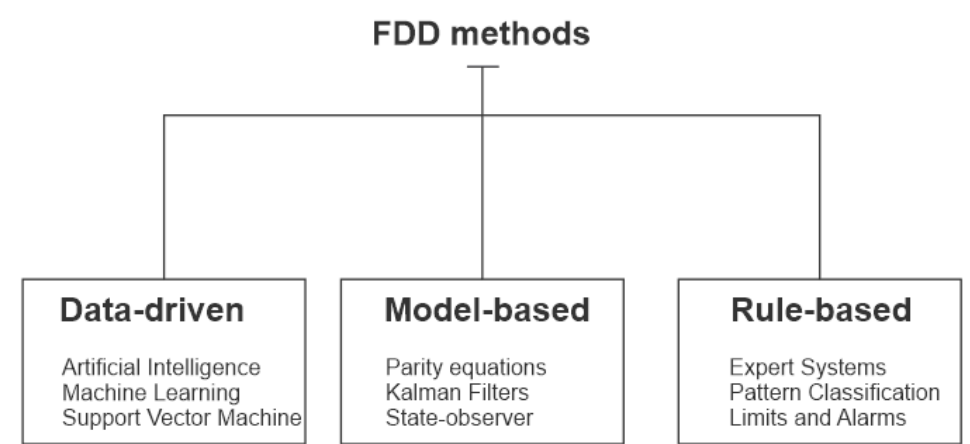
Figure 5. Diagram adapted from the classification of FDD methods [9].